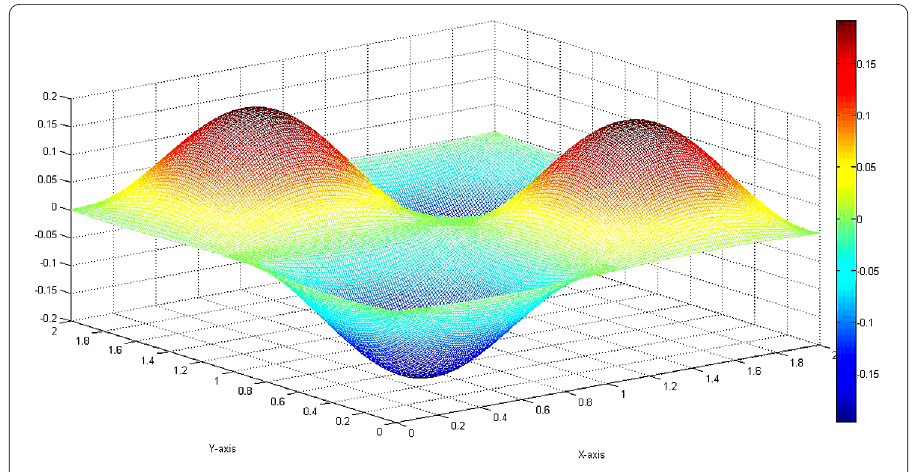
Figure 3 The classical FDCN solution at t = 1.